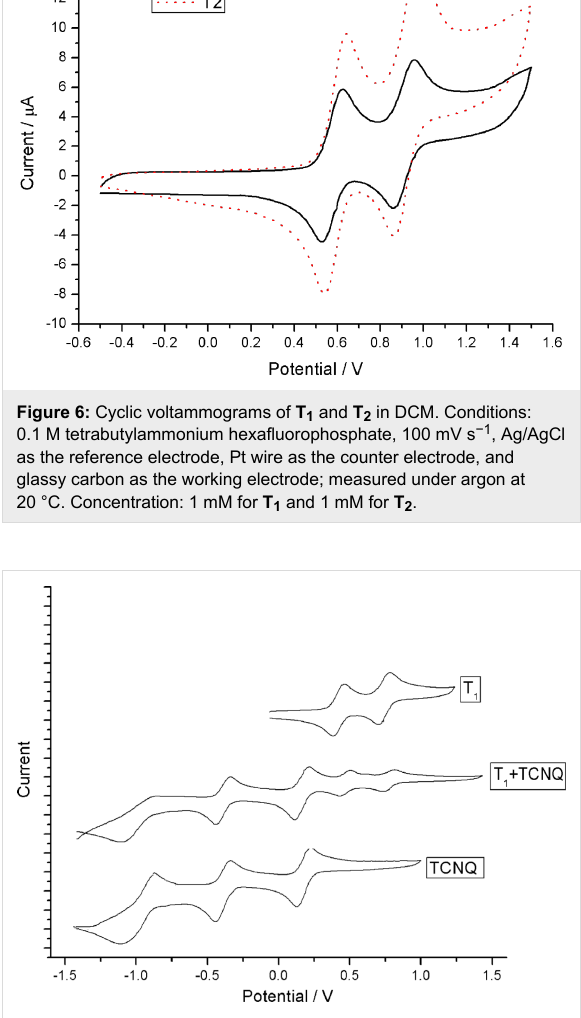
Figure 7: Cyclic voltammograms of T 1 and TCNQ in DCM. Conditions: 0.1 M tetrabutylammonium hexafluorophosphate, 100 mV s − 1 , satu- rated calomel electrode (SCE) as the reference electrode, Pt wire as the counter electrode, and glassy carbon as the working electrode; measured under argon at 20 °C. Concentration: 1 mM for T 1 and 1 mM for TCNQ.